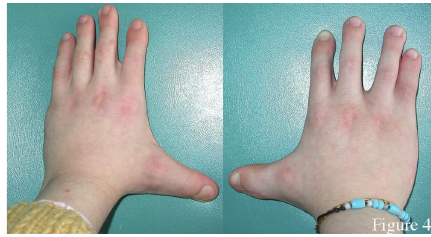
Figure 4: Hands of the patient. Note the surgery scars.